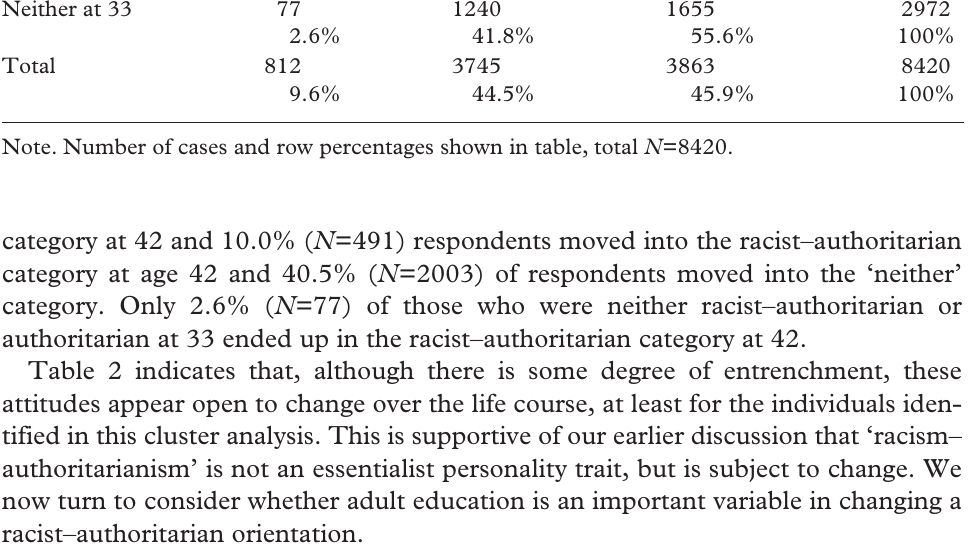
Note. Number of cases and row percentages shown in table, total N